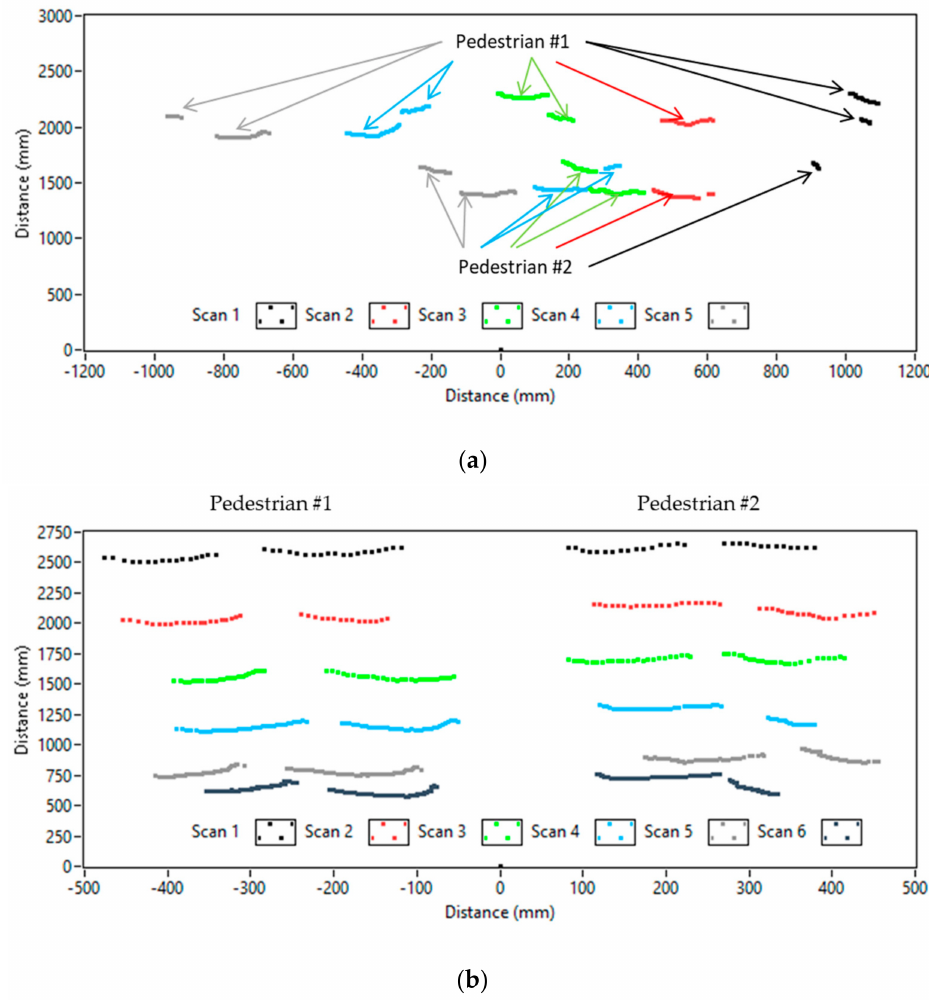
Figure 21. Extracted trajectories of two pedestrians walking ( a ) straight-ahead, and ( b )